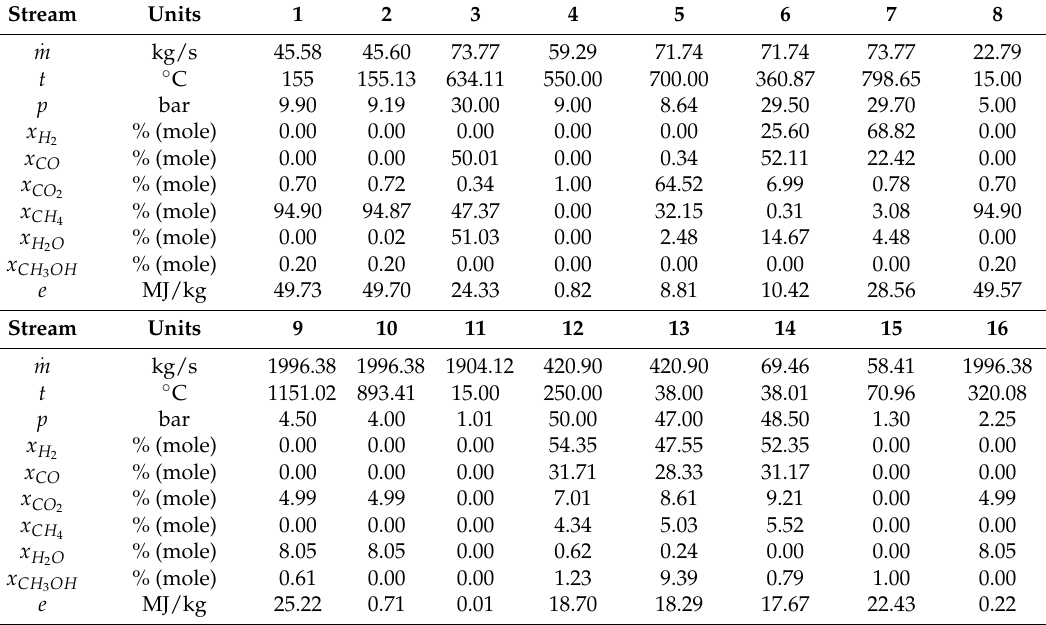
Table 5. Stream data of the methanol plant with parallel steam-methane and dry reforming (Case III).